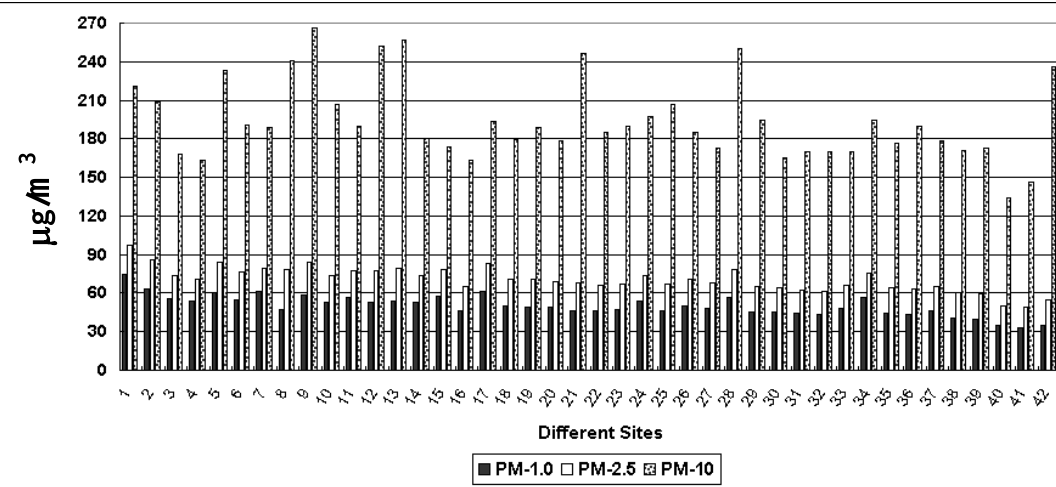
Figure 6. Mean concentrations of particulate matter in the cold